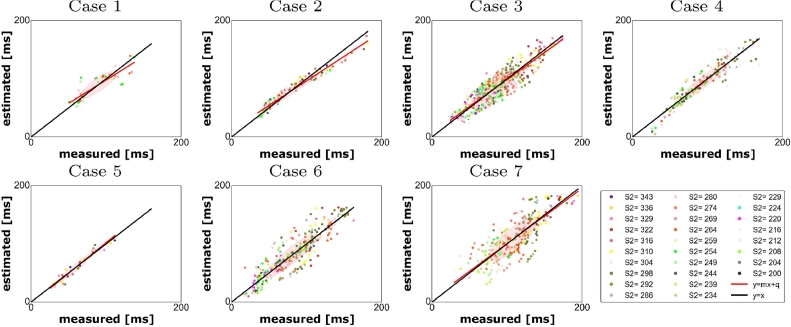
Measured vs estimated activation times for the personalised model (CS). Each point represents a measured vs computed LATs at each electrode and for each s2; each colour represents the measurements taken at the electrodes for a fixed s2 value.